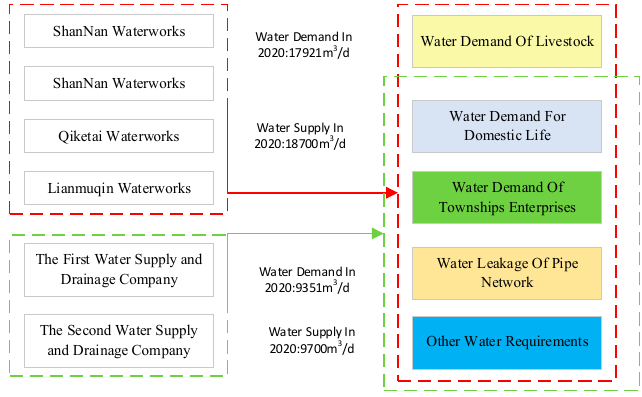
Figure 4. Structure of water supply and demand for the waterworks. Water 2018 , 10 , x FOR PEER REVIEW